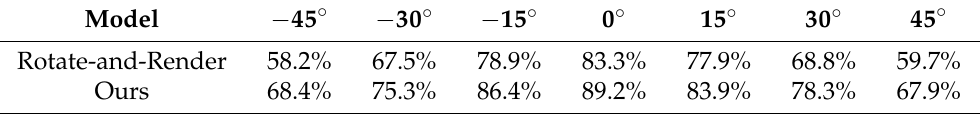
Table 2. Comparison of top-5 recognition ratios between our model and Rotate-and-Render [3]. Model